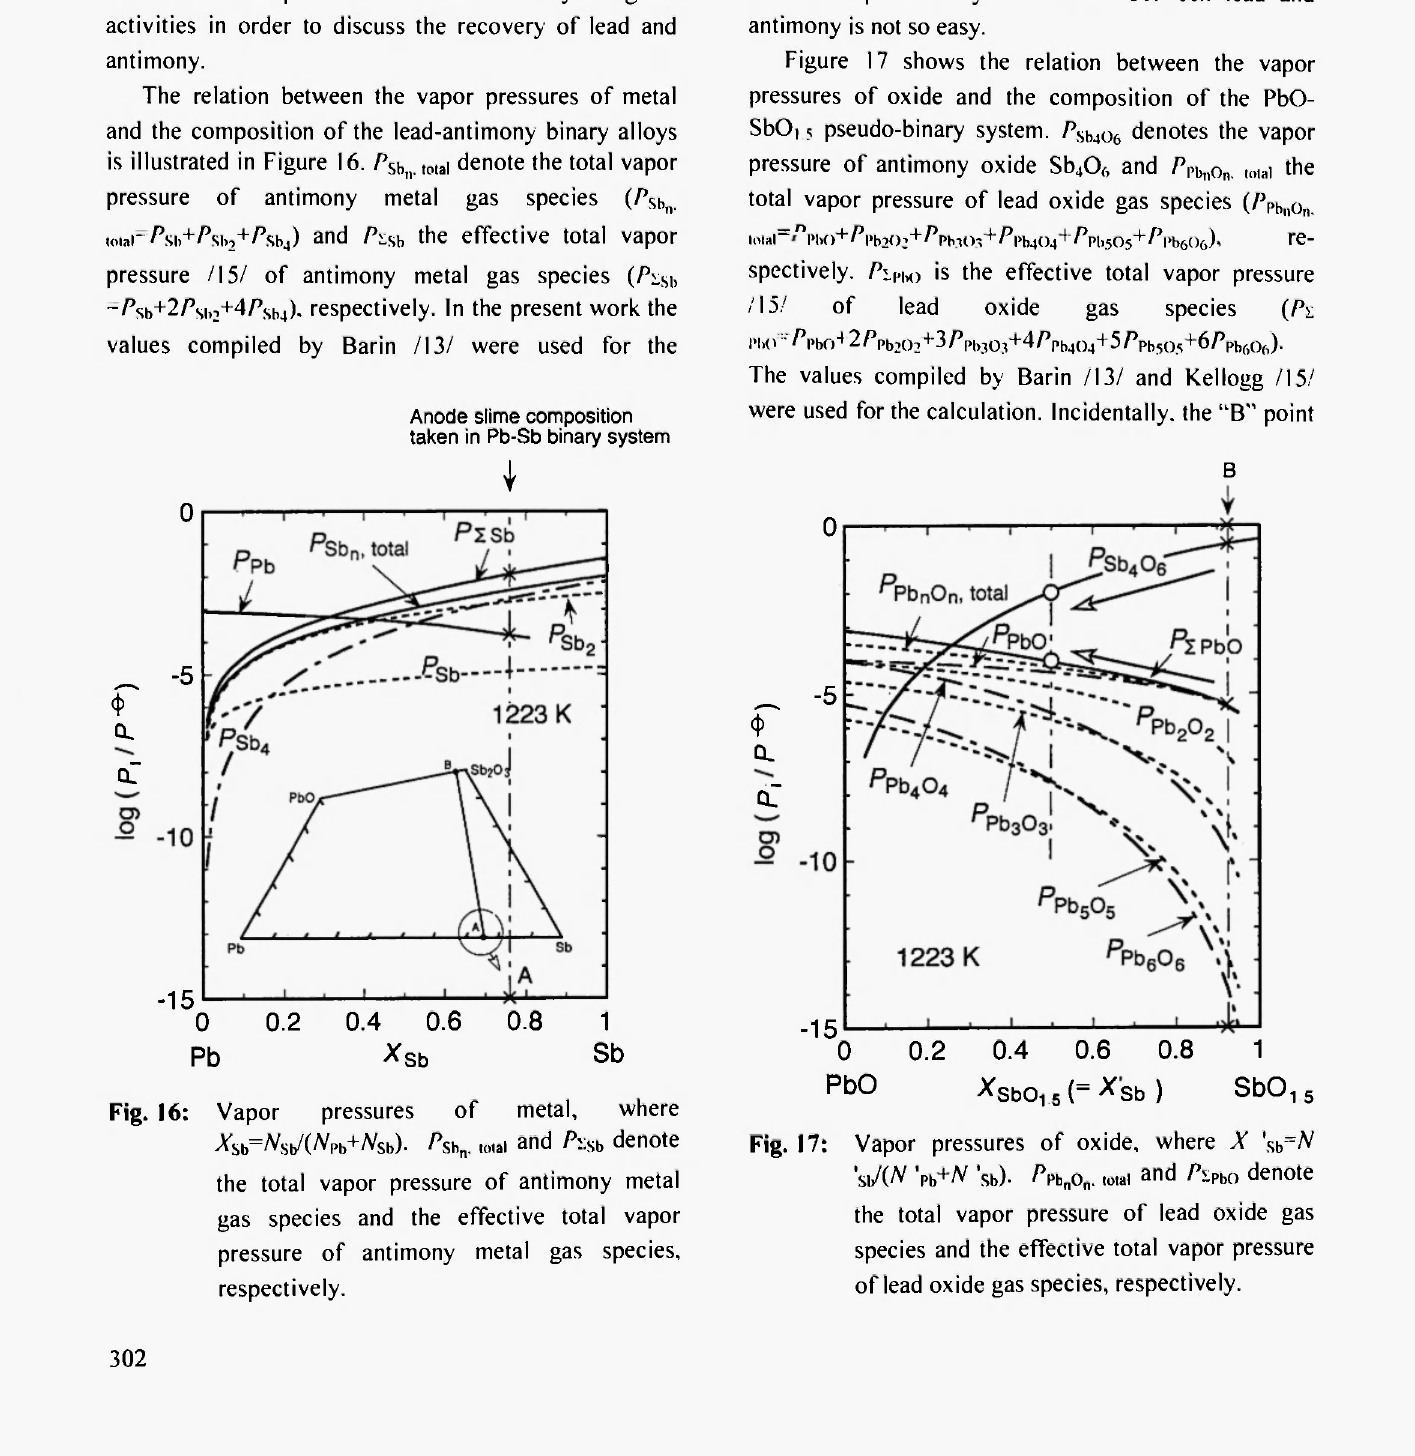
Fig. 16: Vapor pressures of metal, where *sb=/Vsb/(/Vpb+/Vsb)· Ps K total and ft»b denote the total vapor pressure of antimony metal gas species and the effective total vapor pressure of antimony metal gas species, respectively.